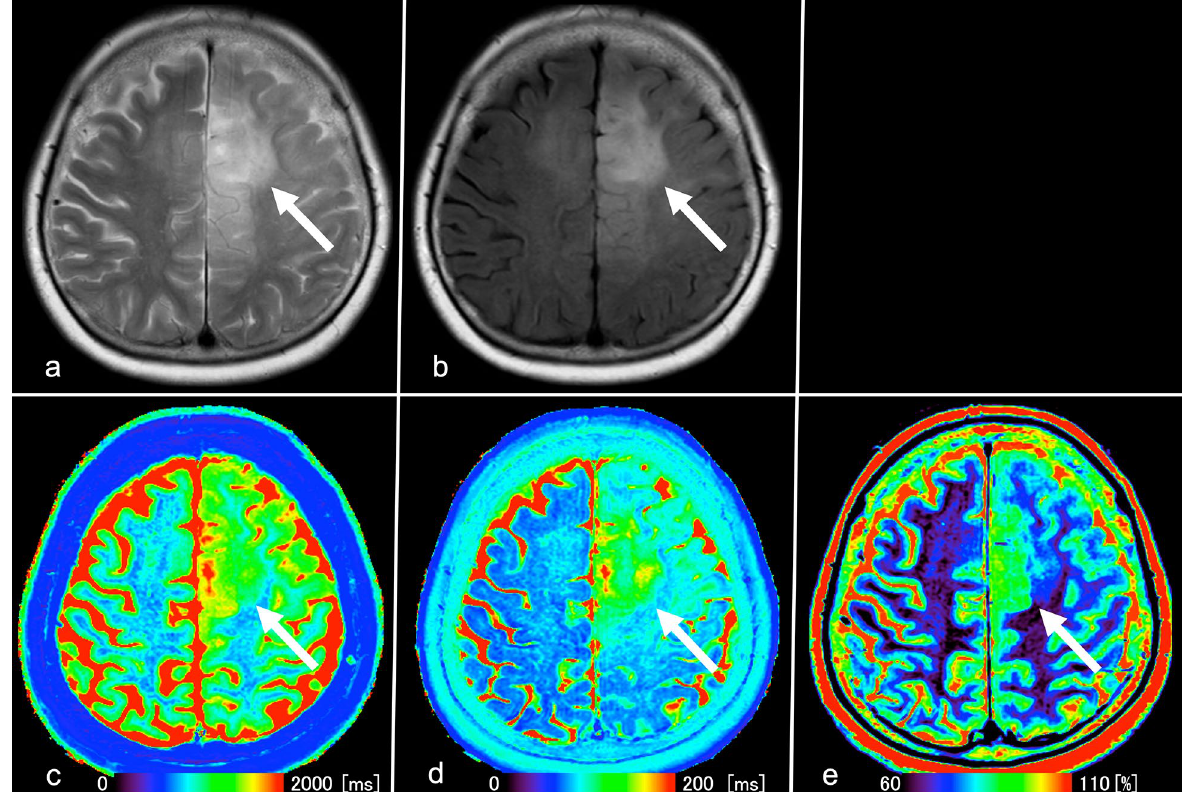
Figure 4. Images from a 63-year-old woman with IDH-mutant and 1p/19q-codeleted oligodendroglioma (WHO grade II). ( a ) T2WI shows a heterogeneous, poorly circumscribed mass in the left frontoparietal lobes. ( b ) FLAIR shows no signal suppression in the tumor, indicating no T2-FLAIR mismatch sign (arrow). ( c ), ( d ), ( e ), T1 and T2 relaxation time and proton density (PD) maps derived from SyMRI show mild T1 (1119 ms*) and T2 (103 ms*) relaxation time prolongations and mildly increased PD (76.8%*) (arrows) in the tumor. *Each value is expressed as the